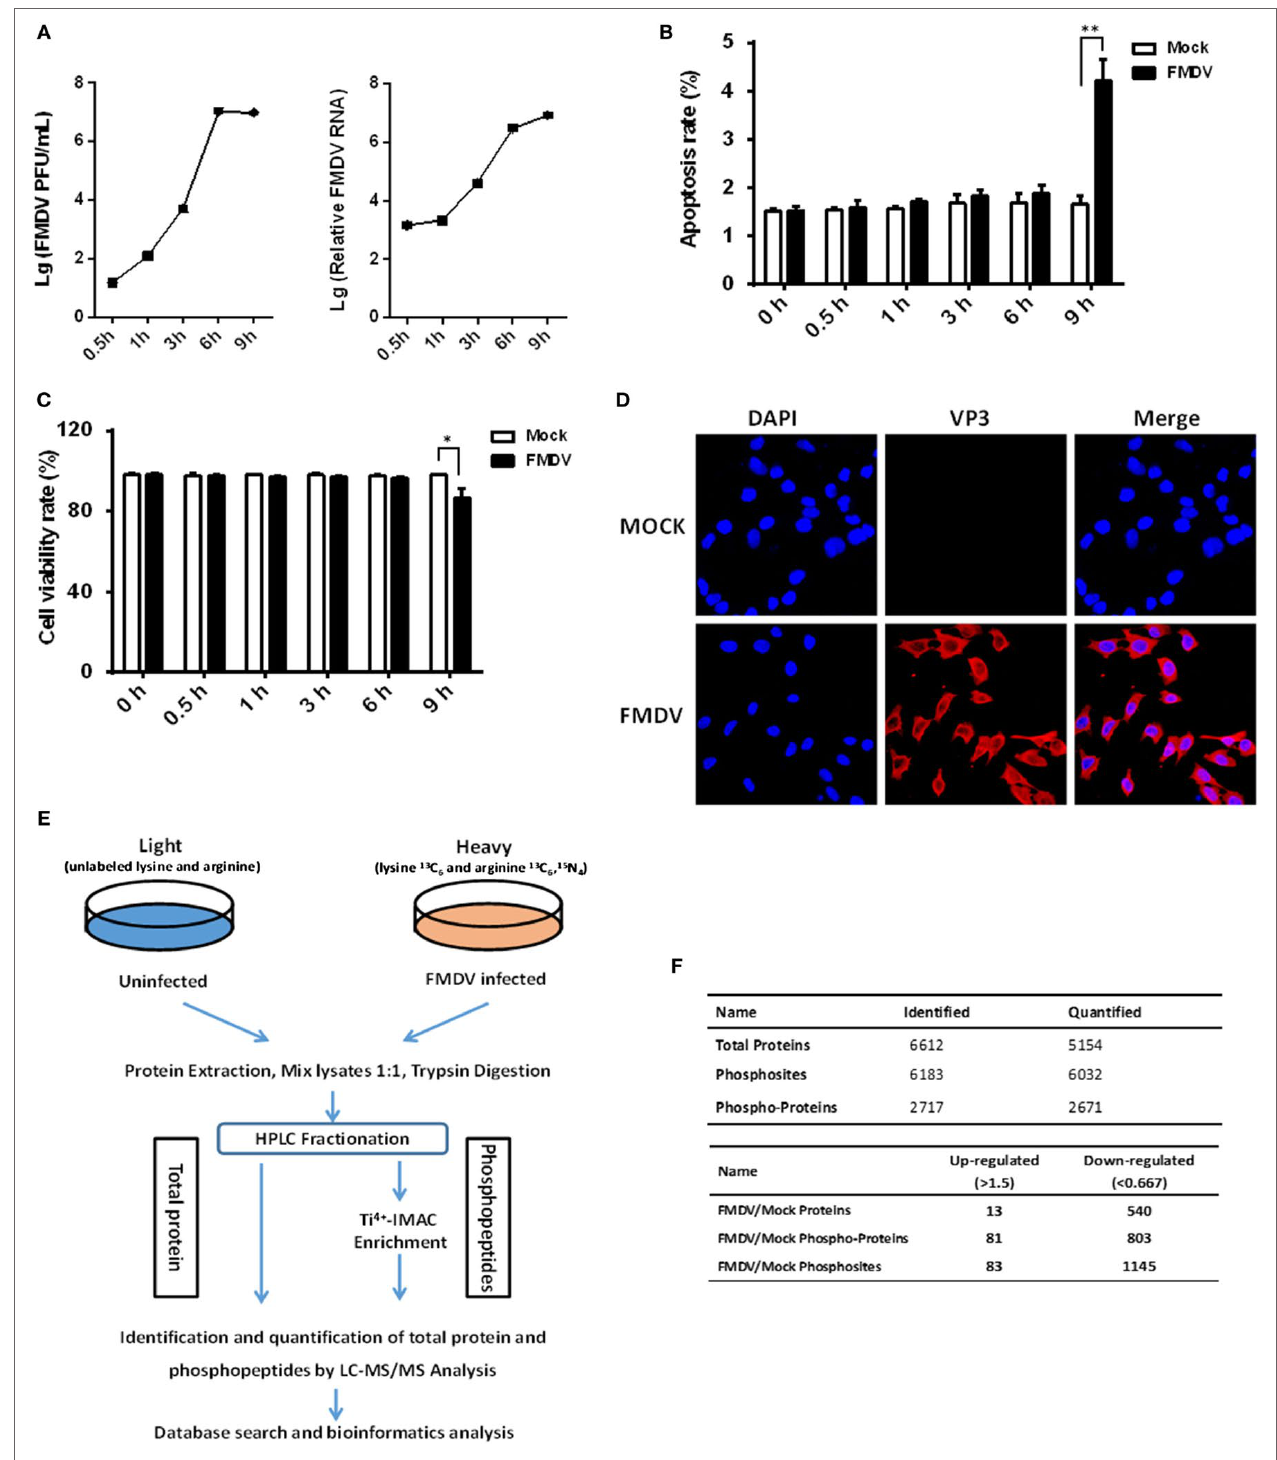
FigUre 1 | Experimental strategy of proteome and phosphoproteome analysis for foot-and-mouth disease virus (FMDV)-infected IBRS-2 cells. (a) IBRS-2 cells were infected with FMDV (MOI = 5) for the times indicated. After this, total cell lysates were prepared and analyzed for virus titer and genome RNA by virus plaque and real-time PCR. (B,c) The experiments were similarly performed as in (a) . Apoptosis and cell death by necrosis is analyzed by annexin V-FITC/PI apoptosis detection kit (B) and cytotoxicity lactate dehydrogenase activity assay kit (c) , respectively. (D) Dynamics of FMDV proliferation by immunofluorescence staining in the infected IBRS-2 cells at 6 h post-infection and mock-infected cells at 6 h as a control. (e) The workflow for the proteomics and phosphoproteomics experiments. (F) Total number of proteins, phosphoproteins, and phosphosites identification results when pooling the identifications of both biological